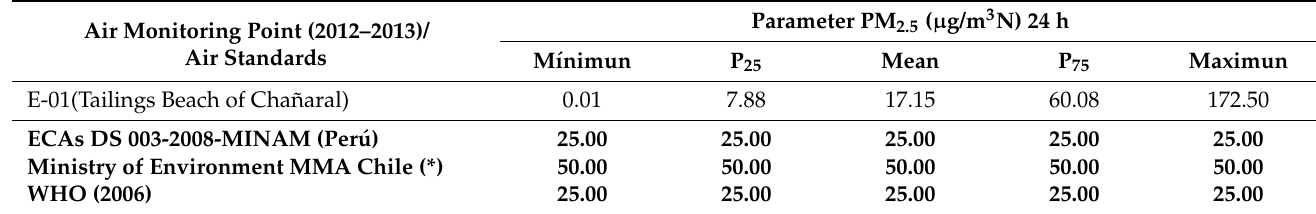
Table 5. Chañaral Tailings Particulate Matter compared with Air Standards